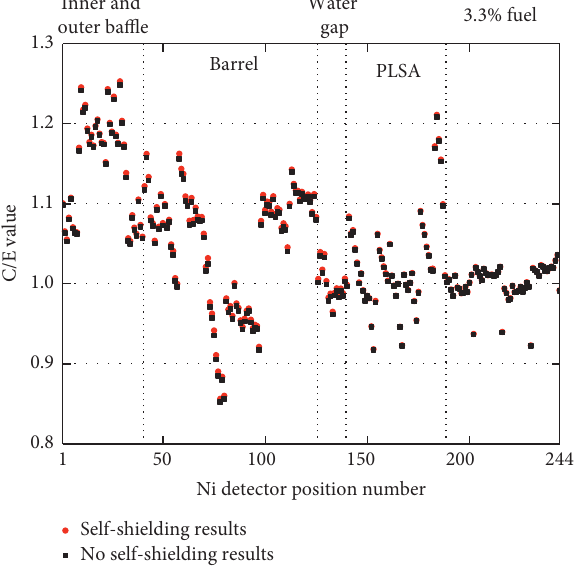
Figure 13: Comparison of self-shielding correction of the 27 Al(n, α ) 24 Na detector.